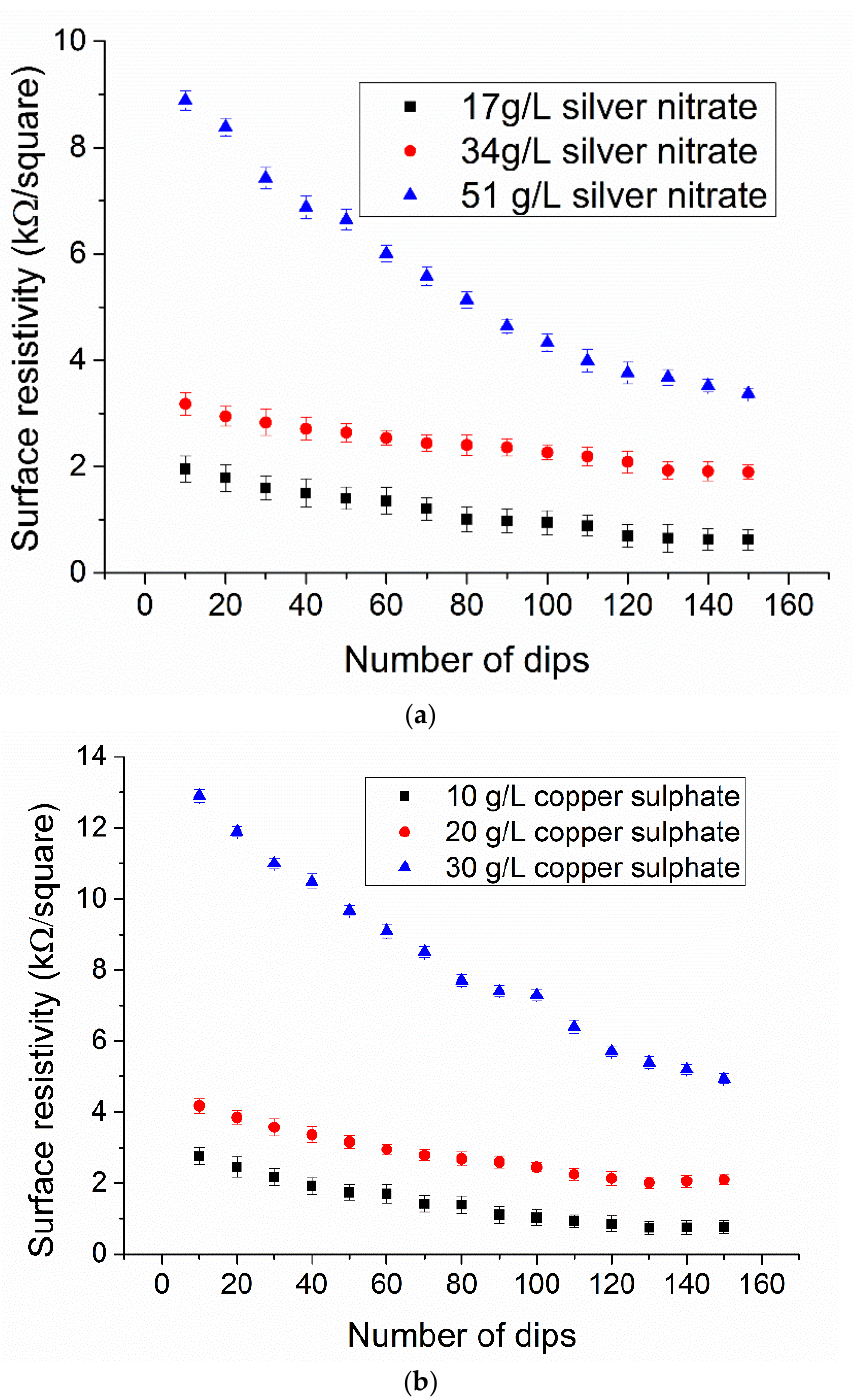
Figure 6. Effect of ( a ) silver nitrate, ( b ) copper sulphate concentrations and dipping on electrical resistivity (bars are limits of 95% confidence interval).